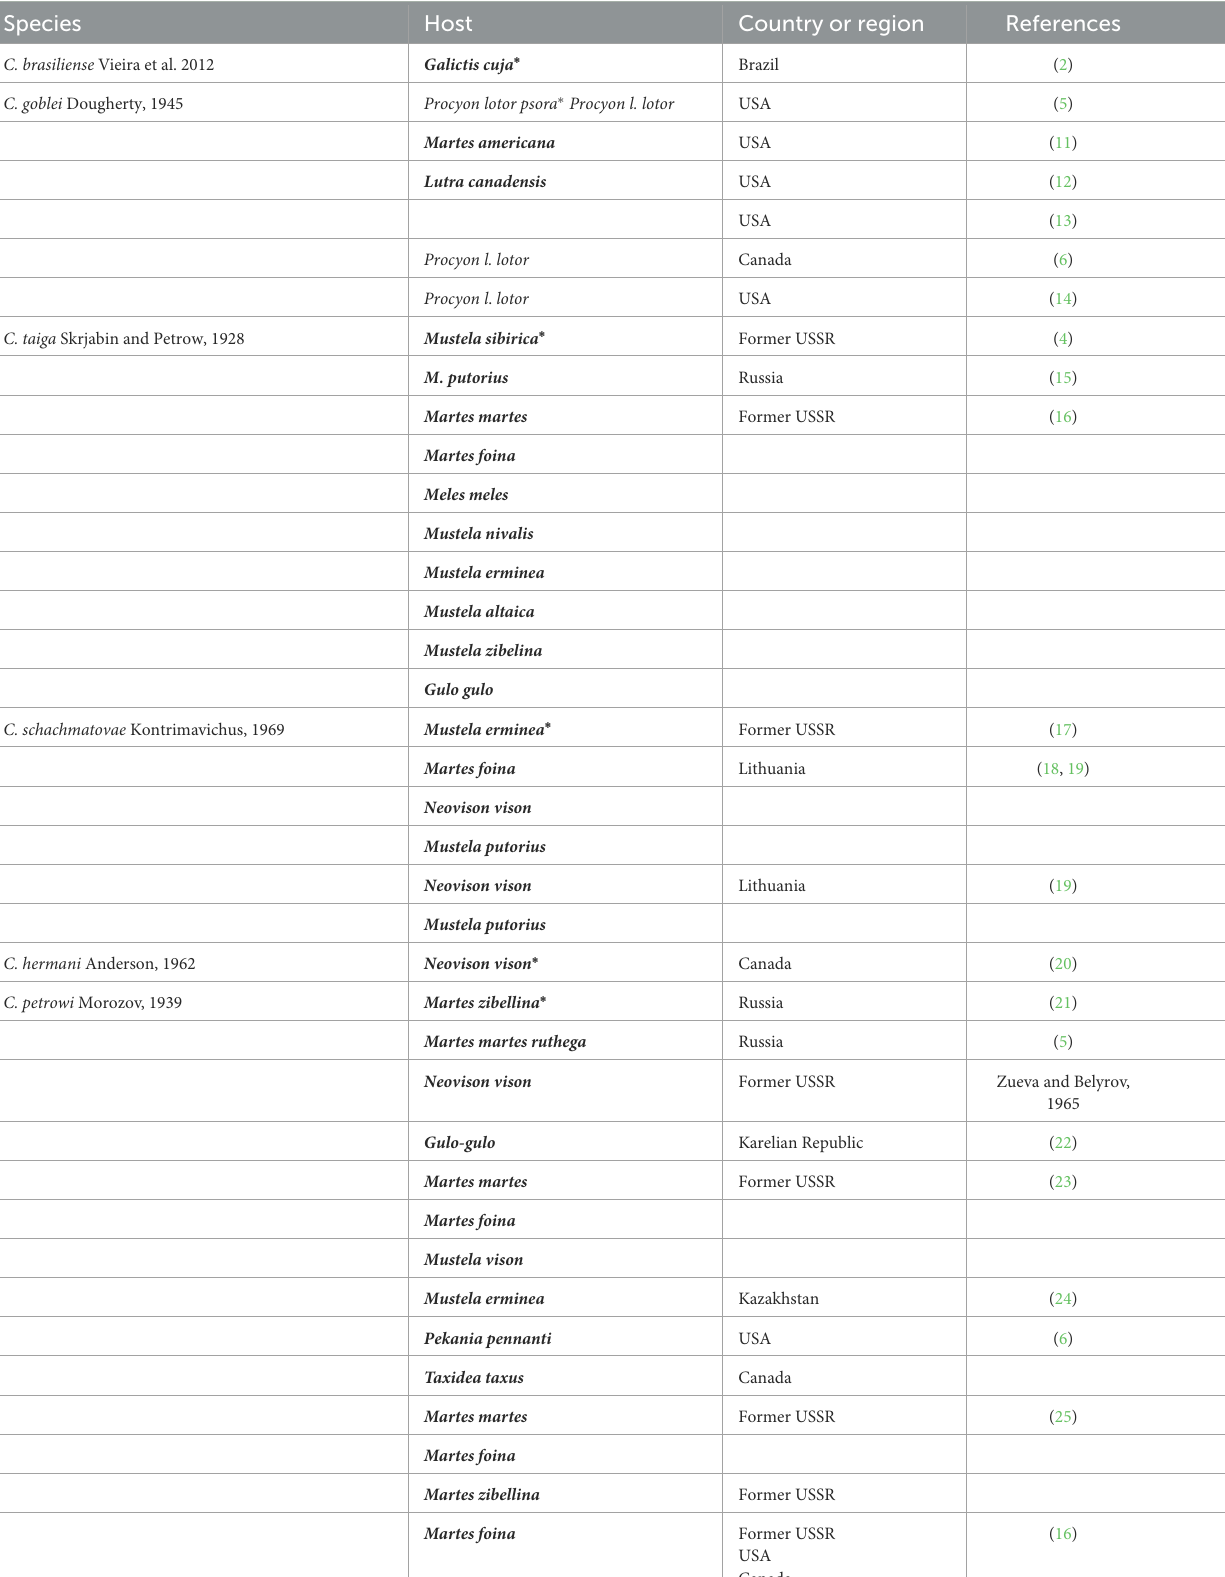
TABLE 1 Species of Crenosoma identified in mustelids: hosts and geographical distribution. Species Host Country or